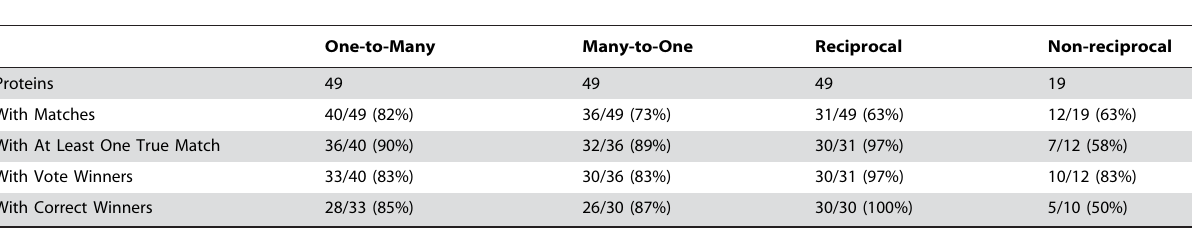
Table 2. ETA Annotation of PSI Test Set.